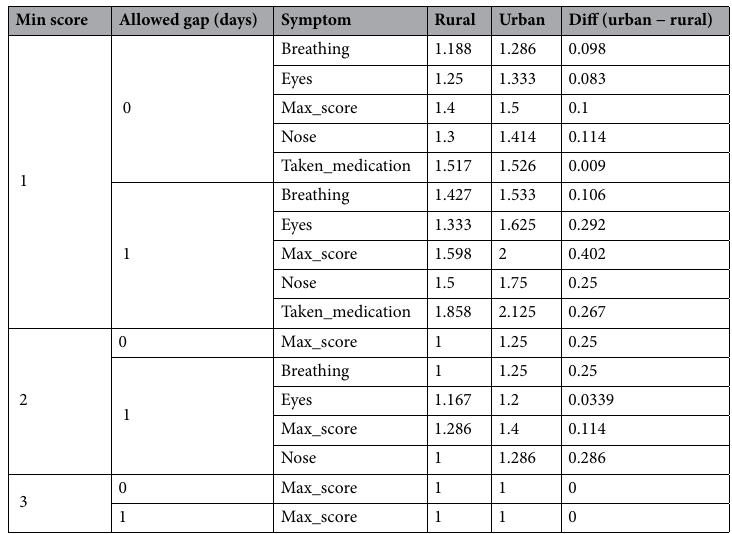
Table 2. Urban vs rural symptom duration: medians of the user average (mean) duration of symptoms in days (March–Sept incl.). Except for tests using maximum symptom score ( max_score ), all rows where the difference is zero are